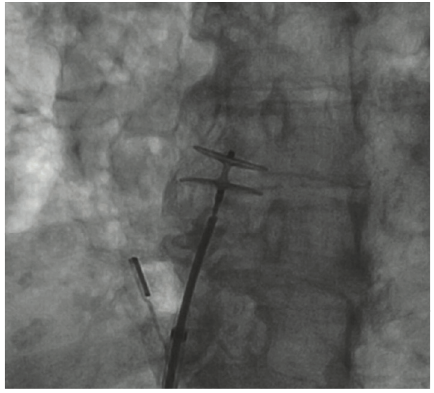
Figure 2: Fluoroscopic positioning and deployment of 18mm Amplatzer Cribriform Septal